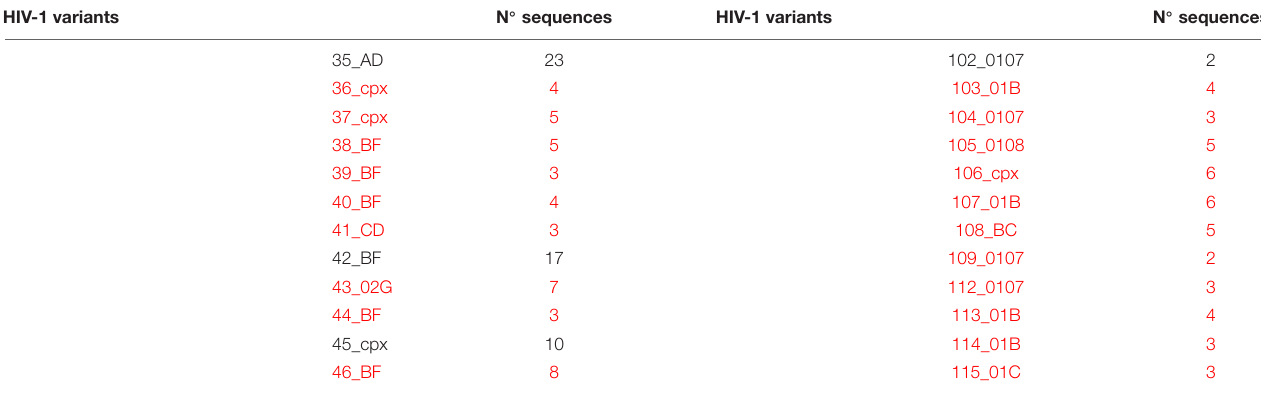
HIV-1 group were used to analyze the aa variability of each residue in the p24 secondary structure domains, as illustrated in Figure 1 . The HXB2 reference sequence was included for further guidance. The mean p24 aa conservation for the HIV-1 consensus was 89%. For groups M, N, O, and P, it was 94, 96, 95, and 98%, respectively. The mean aa conservation percentage of p24 compared to HXB2 reference sequence across HIV-1 groups was 93.6% (group M), 80.2% (group P), 79.1% (group O), and 85.4% (group N), respectively. The aa conservation in the secondary p24 structure varied between HIV-1 variants, amino acid residues, and type of secondary structure. None of the structural regions presented 100% conservation across variants. In HIV-1 consensus, the most conserved structure was helix 8 (98%), followed by the MHR (97%). Both regions overlap at the beginning of p24 CTD ( Figure 2 ). The least conserved region was helix 6 (76%), followed by the Cyp A-binding loop (83%). As for the HIV-1 groups ( Tables 2 , 3 ), group P showed the lowest conservation vs. other groups in the IDR (83.3 vs. 94–100%), while group O showed the lowest conservation of the β -hairpin (84.4 vs.